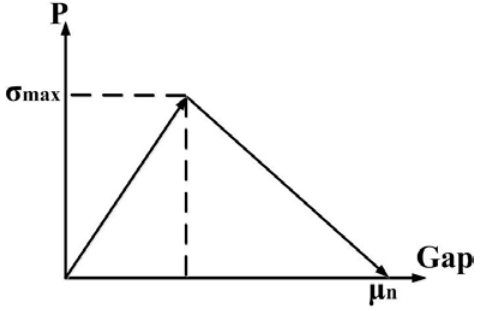
Figure 5. Normal contact stress and contact gap curve. Figure 6. Normal contact stress and contact gap curve. Figure 6. Normal contact stress and contact gap